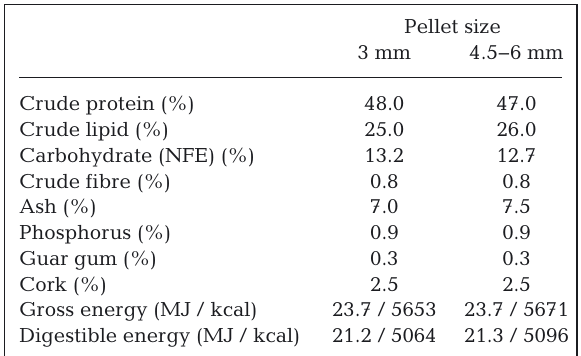
Table 1. Commercial declaration of the control diet EFICO Enviro 921 (BioMar) plus guar gum (SEAH International). Control diet composition included fish meal (LT94), fish oil, soy concentrate, haemoglobin meal, rapeseed oil, pea protein, vitamins and minerals. For the trial, the basic diet was supple- mented with 2.5% cork Quercus suber granules ( ∅ 0.5−1 mm, Amorim) as well as guar gum (‘gomme de guar’, HV 109 [Code: 3309]; SEAH International). NFE: nitrogen-free